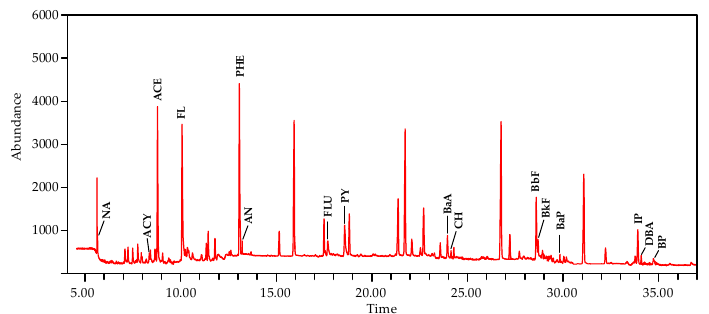
Figure 2. GC/MS selected quantification ion chromatograms of 16 PAHs in the T4 seawater sample. The definitions of compound abbreviations see Table